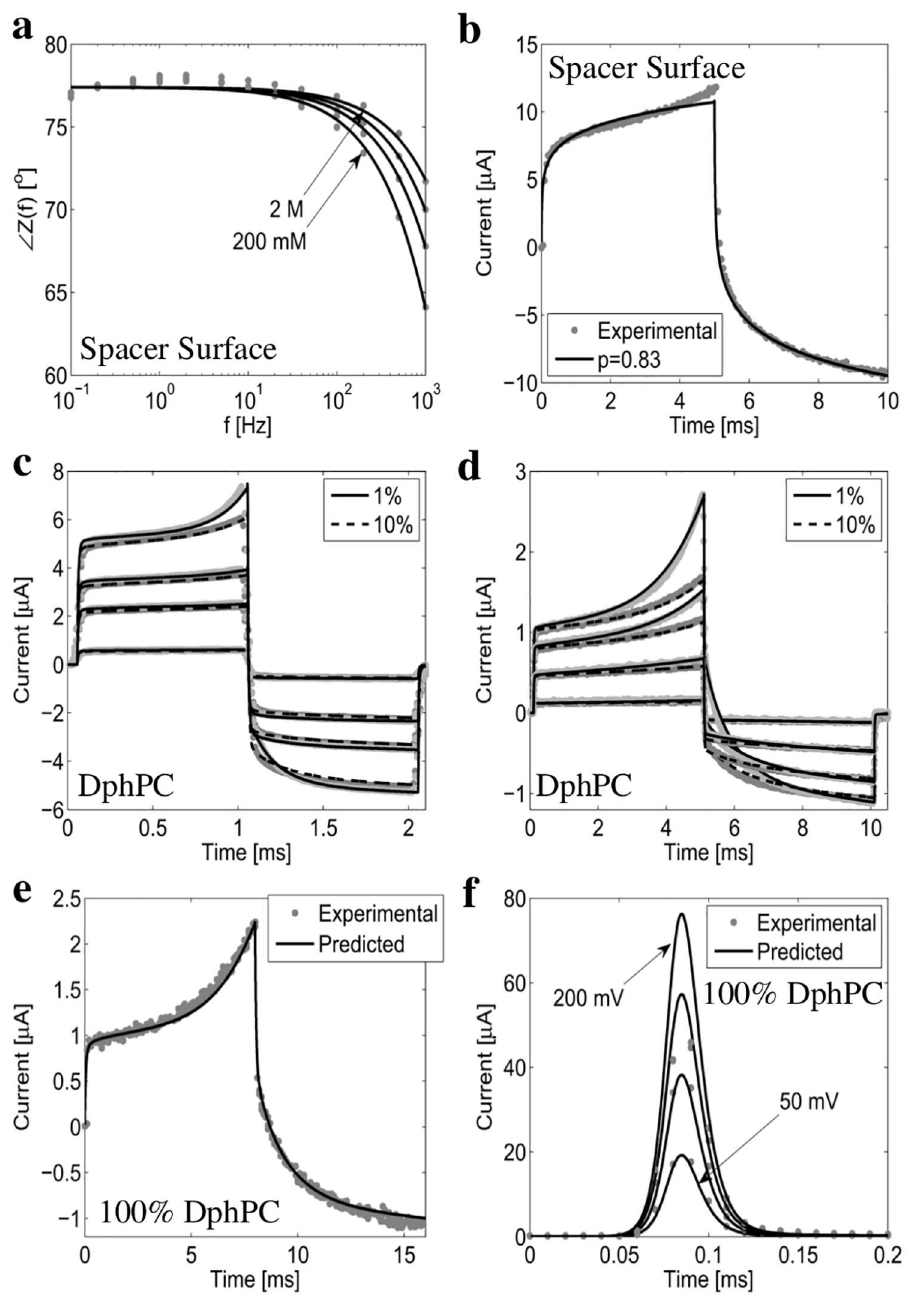
Fig 4. Experimentally measuredand numerically computed current response of the tethered membrane. (a) and (b) providethe measured and computedphase and current response of the spacer surface. Note C m ! 1 and G m = 0 as the membrane is not present. (c) to (f) providethe experimentally measured and numerically computed current response I ( t ) for 1%, 10%, and 100% tethered DphPC membranes. In (c) the drive potential V s ( t ) is defined by a 1 ms linearlyincreasingpotential with a slope of 10 V/s, 40 V/s, 70 V/s, and 90 V/s followedby a 1 ms linearly decreasingpotential with identicalslope. In (d) V s ( t ) is a 5 ms linearly increasing potential with slope of 50 V/s, 200 V/s, 300 V/s, and 450 V/s followedby a 5 ms linearly decreasingpotential with identicalslope. In (e) V s ( t ) is defined by a 8 ms linearlyincreasing potential with a slope of 100 V/s followedby a 8 ms decreasing potential with identicalslope. In (f) V s ( t ) is a step of 50 mV, 100 mV, 150 mV, and 200 mV. All numericalresults are computed using the fractional order macroscopic model provided in the S1